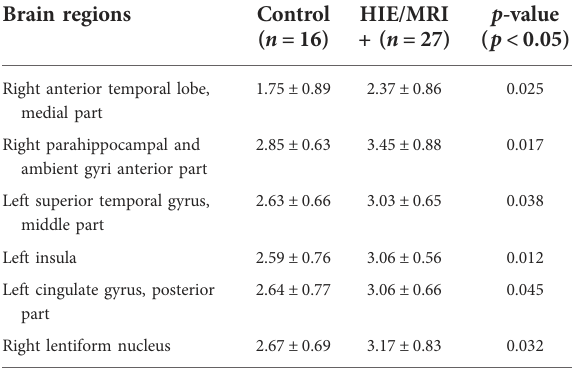
TABLE 4 Brain regions with signi fi cant APT signal intensity differences between the control and HIE/MRI+